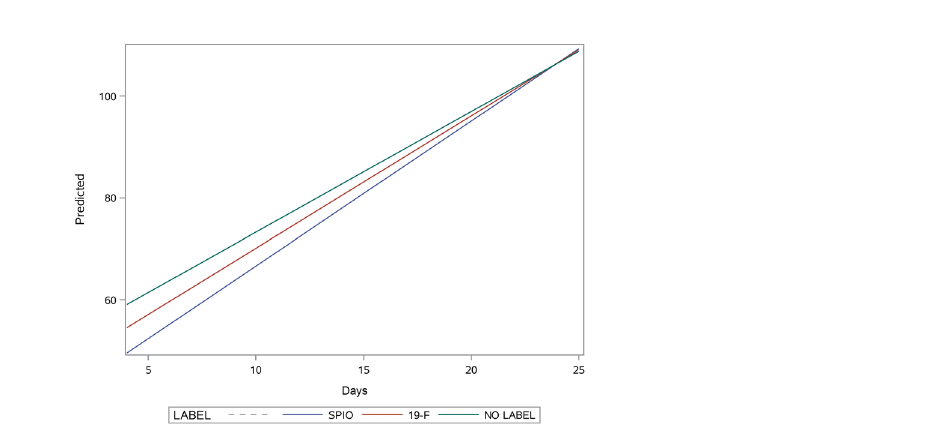
Figure 3. Representative images of the wound-healing process at day 9 across all experimental groups.